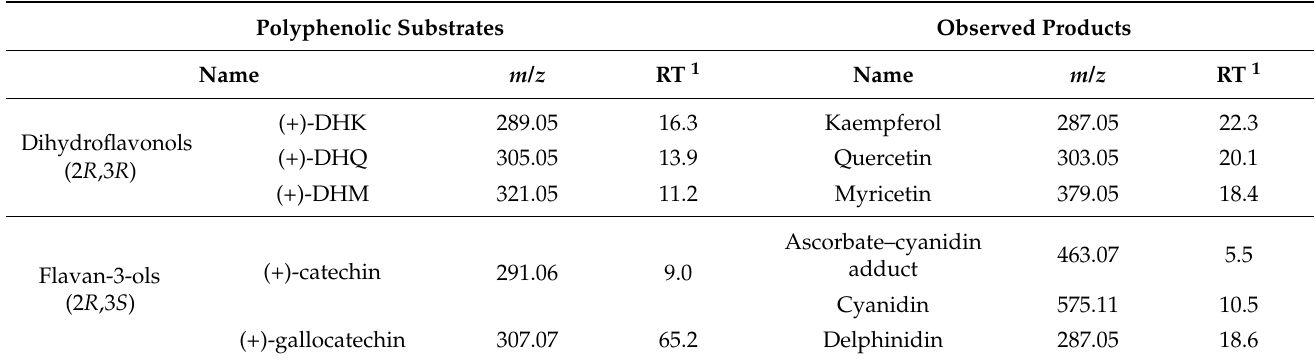
Table 1. Enzymatic products obtained from the reactions catalyzed by Vv ANS. Polyphenolic Substrates Observed